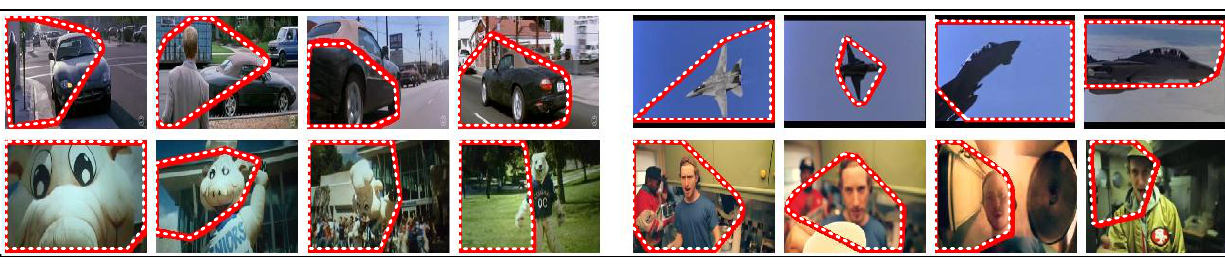
Figure 12. Region detection results for 4 objects.